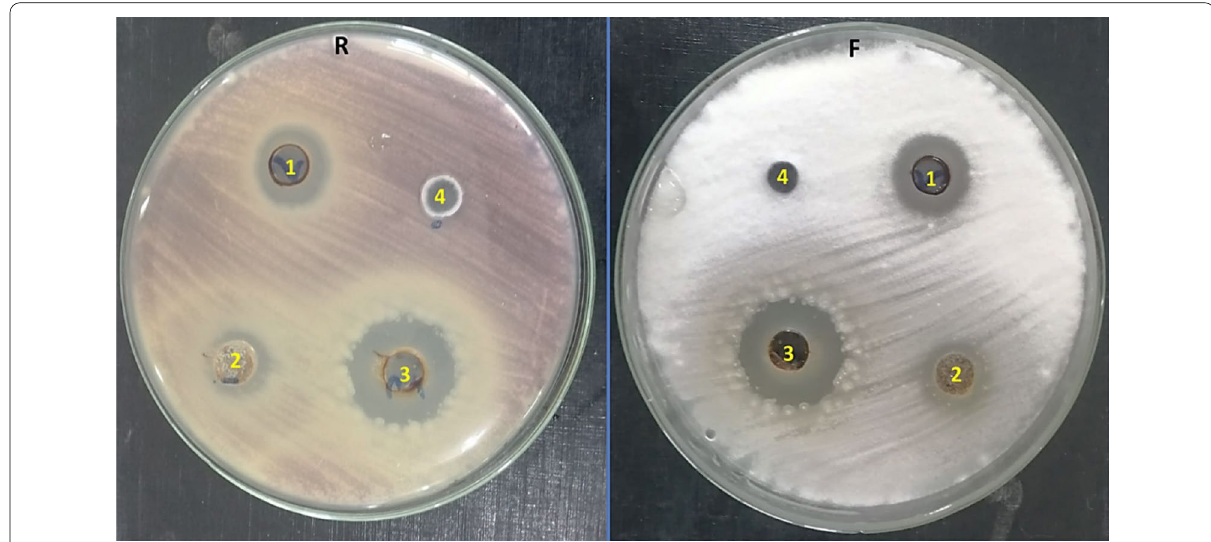
Fig. 1 Antifungal activity of (1): A. flavus , (2): A. fumigatus , (3): A. nidulans crude extracts and (4): fluconazole against F. oxysporum using agar well diffusion method. (F front and R reverse) = =